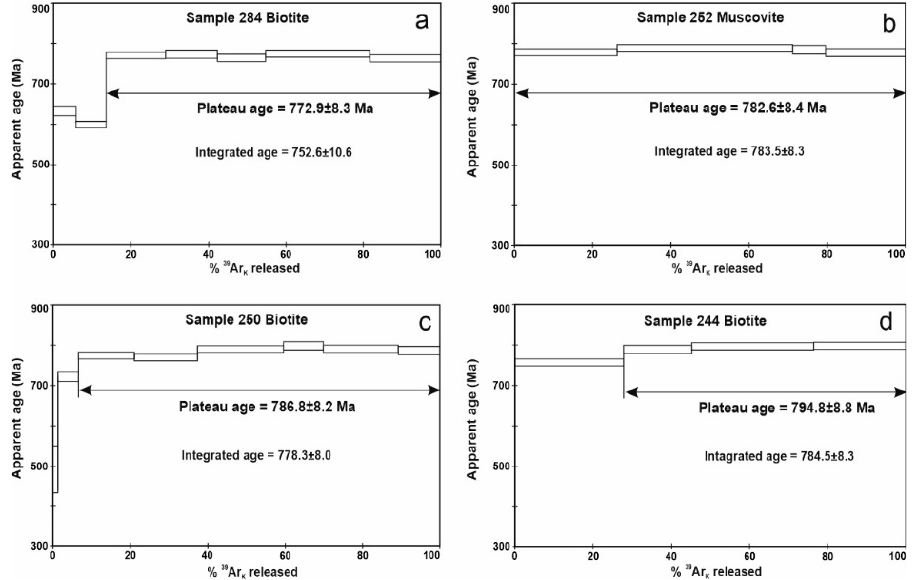
Figure 29. 40 Ar- 39 Ar mica ages for collision-related metamorphic rocks of the Polkan area, where Sample 284 (a) , Sample 252 (b) , Sample 250 (c) , and Sample 244 (d) . Either the plateau (arrows) or integrated age is given for each sample.